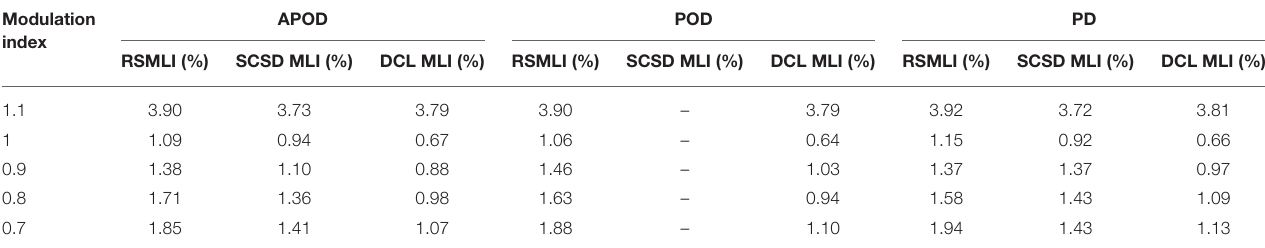
TABLE 4 | Voltage THD comparison of RSMLIs with PWM